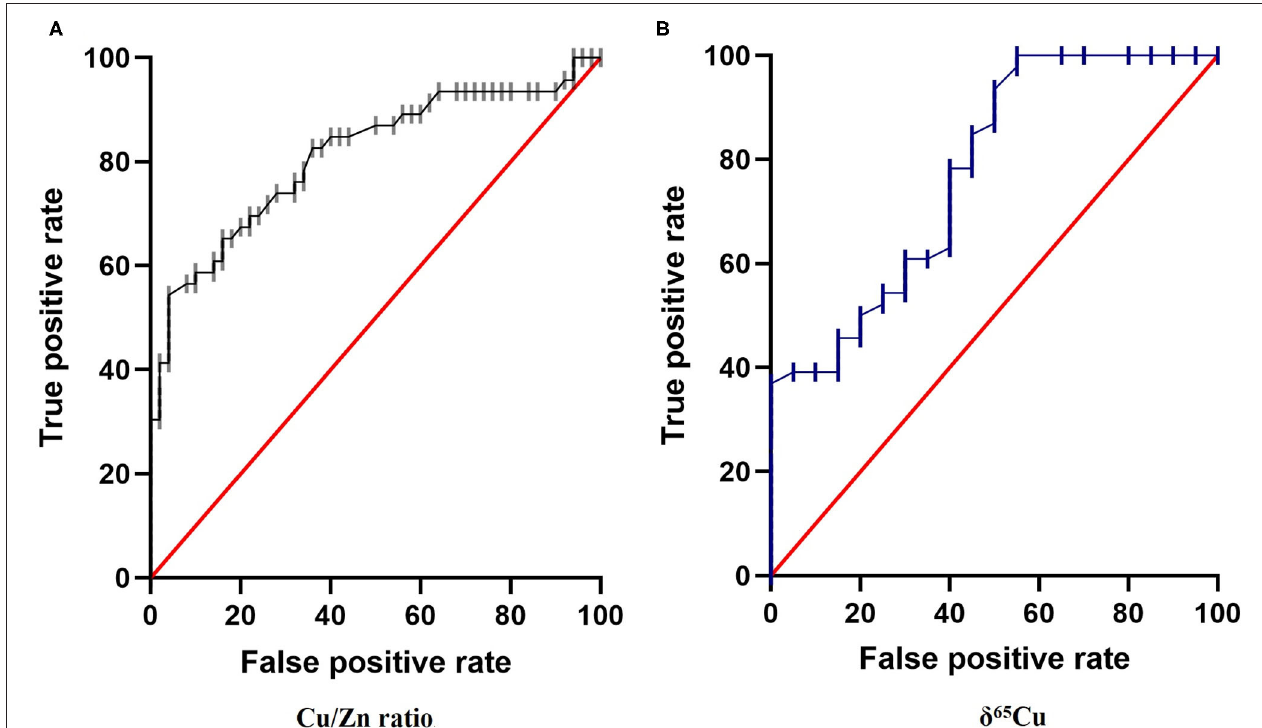
FIGURE 4 | Receiver Operating Characteristics (ROC) curve for: (A) Cu/Zn Ratio and (B) δ 65 Cu in the plasma of papillary thyroid carcinoma. We place the True Positive decision on the ordinate axis and False Positive rate on the abscissa to form the ROC diagram. The area under the ROC curve (AUC) obtained for the present data were 0.81 and 0.78, respectively ( p < 0.001) supports the hypothesis that Cu/Zn ratio and δ 65 Cu have a strong potential to be a novels biomarker in diagnosis for thyroid